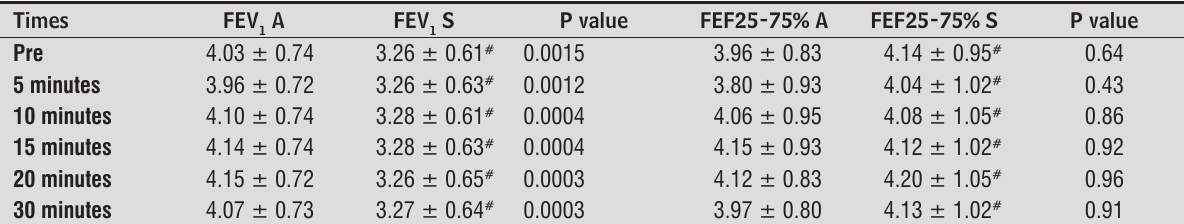
Table 2 - Comparison of the athletes and sedentary individuals, in the spirometric parameters FEV1, FEF 25-75, pre execu- tion of the EIB test and 5, 10, 15, 20, and 30 minutes after the maximum stress test on the treadmill